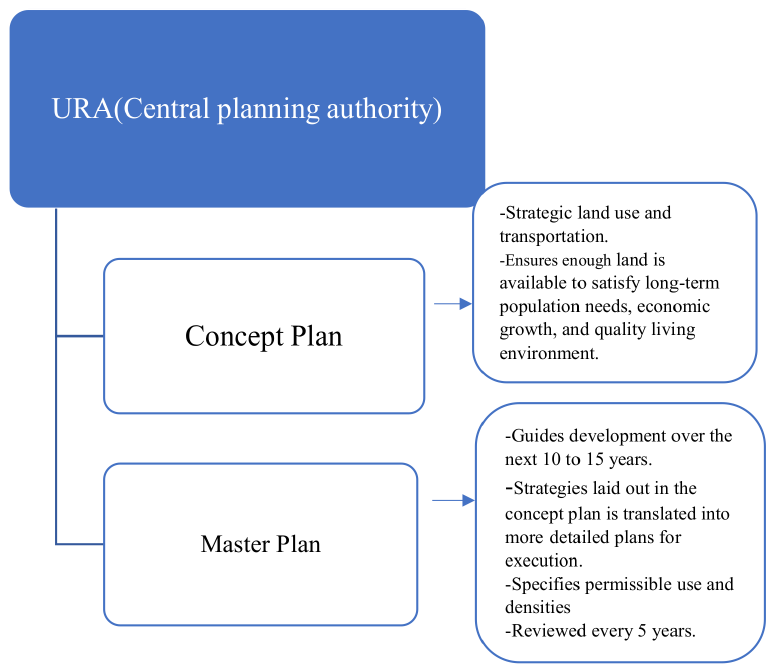
Figure 1: Singapore’s Planning